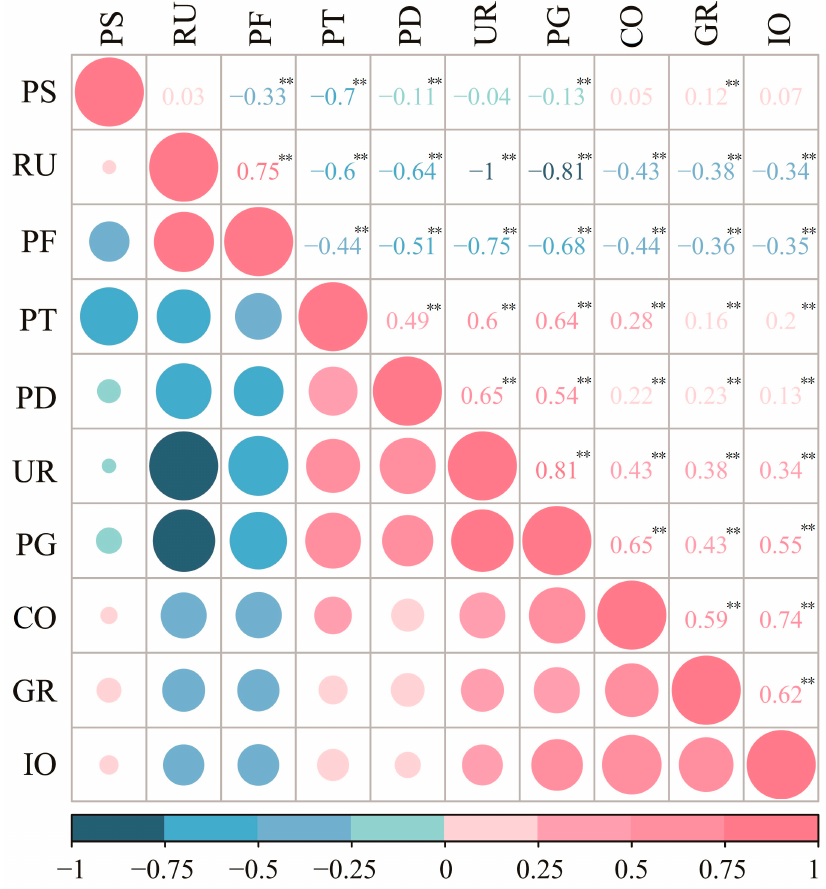
Figure 2. Correlation matrix for socioeconomic factors. Note: PD: population density; UR/RU: the non-agricultural/agricultural proportion of the population; PG: per capita gross domestic product; IO: industrial output; PF/PS/PT: proportion of primary/secondary/tertiary industry; CO: construction output; GR: area of green land. ** statistical significance level: 0.01.